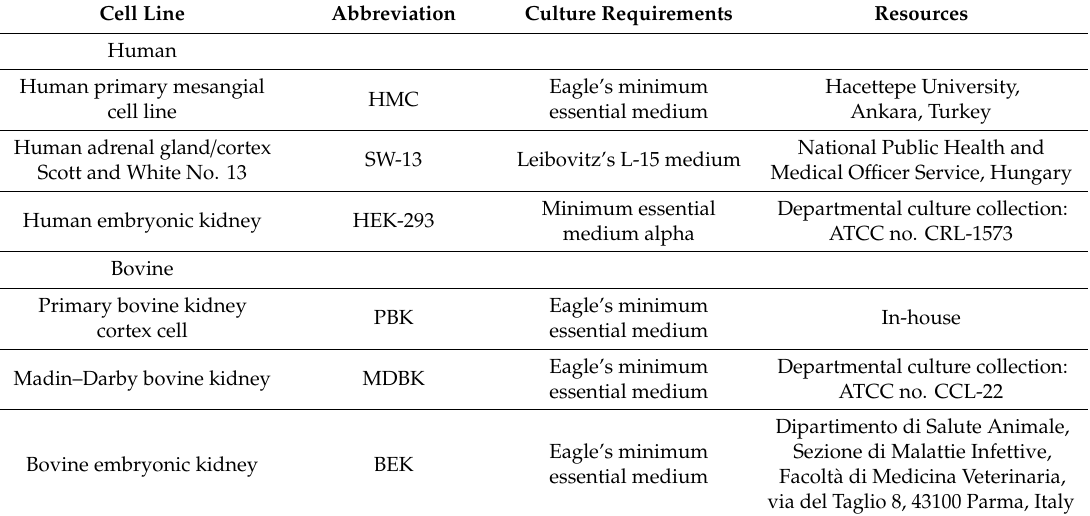
Table 1. Human and bovine cell lines used in the present